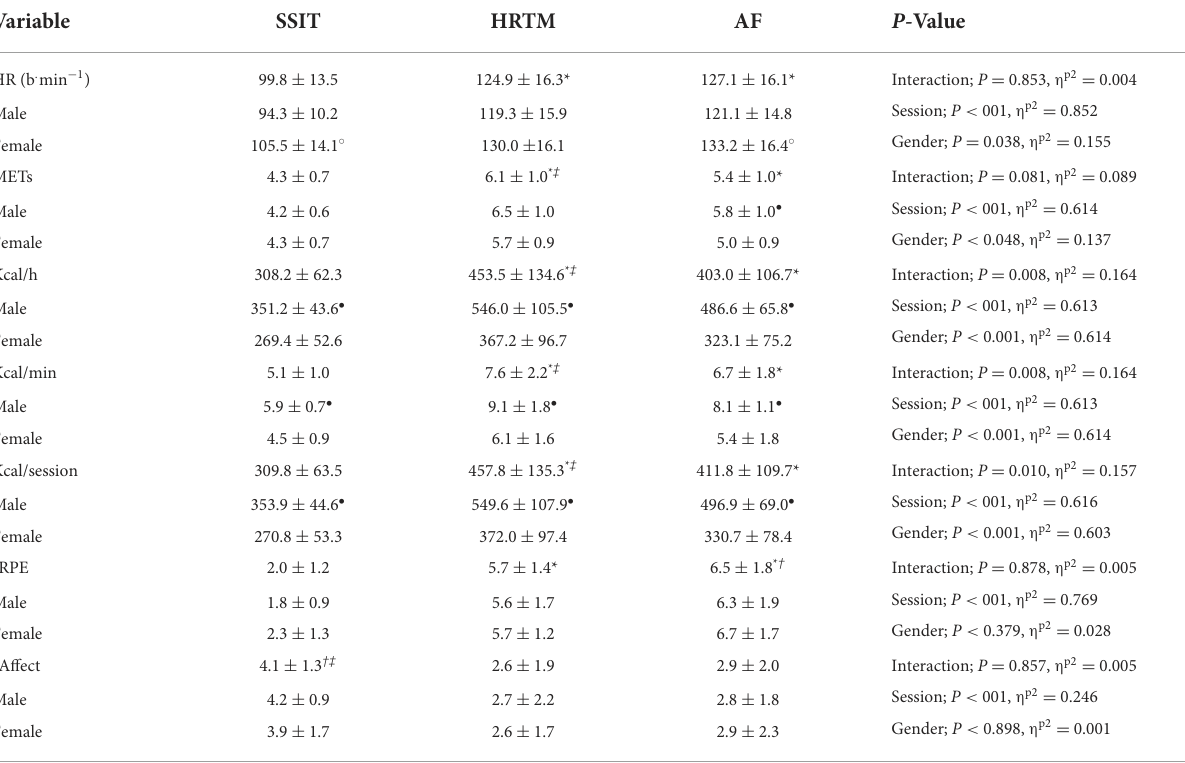
TABLE 3 Comparison of HR, METs, energy expenditure, and perceptual data across sessions (AF, SSIT, HRTM) ( n = 30).